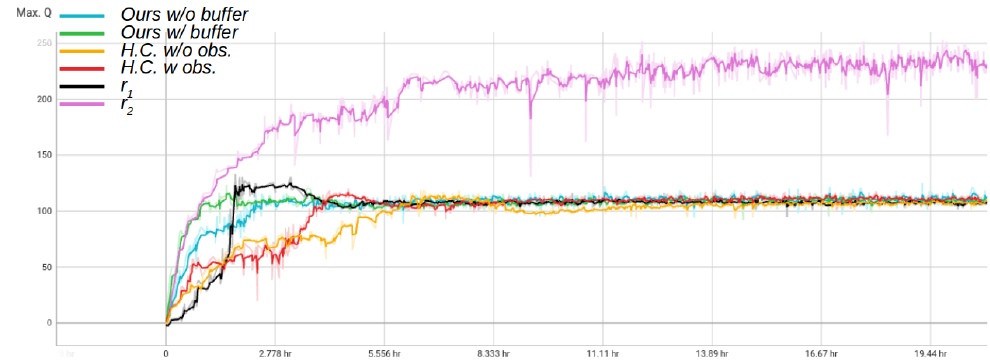
Figure 6. A training time representation of max. Q value per training for each policy. The training time was executed for approximately 20 h for each